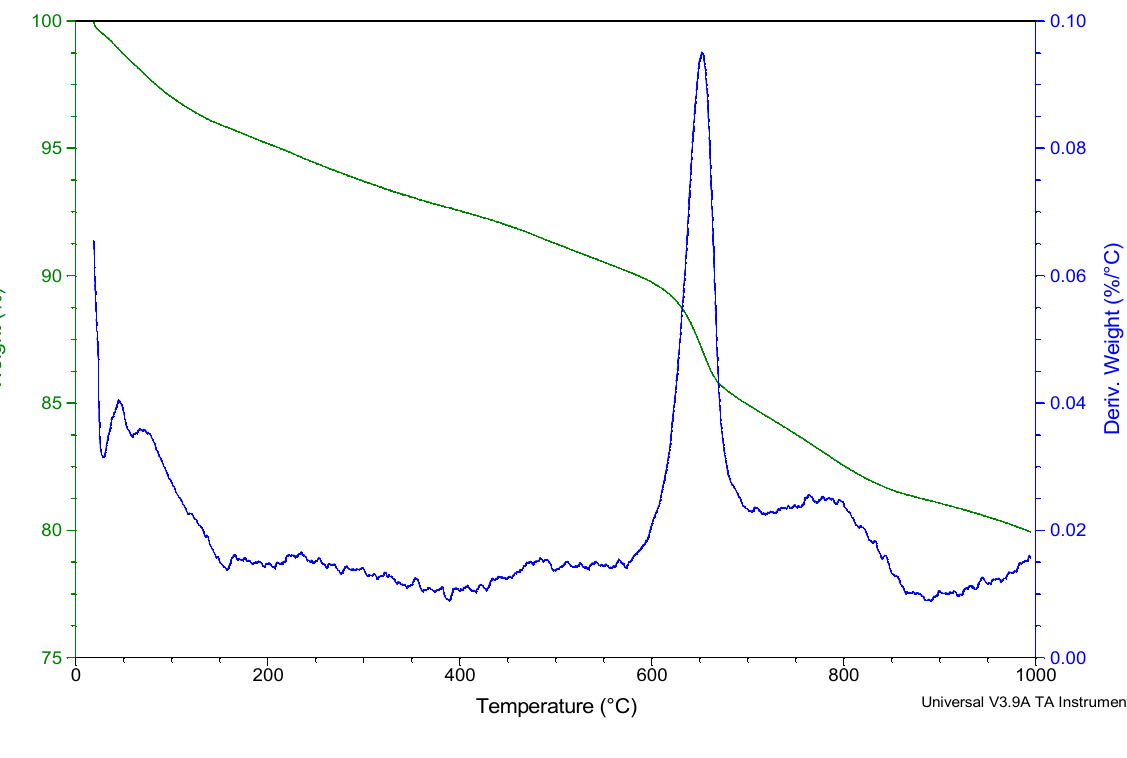
Figure 9. TGA and DTA profiles of sulphated